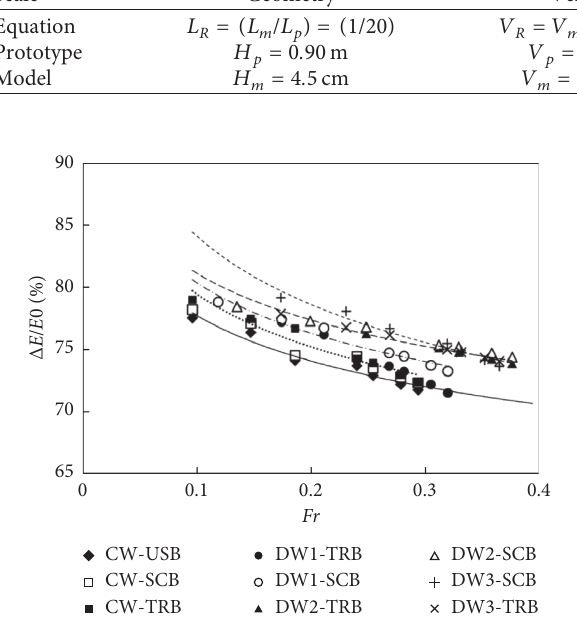
Table 3: Model simulation in the laboratory based on the Froude similarity simulation. Scale